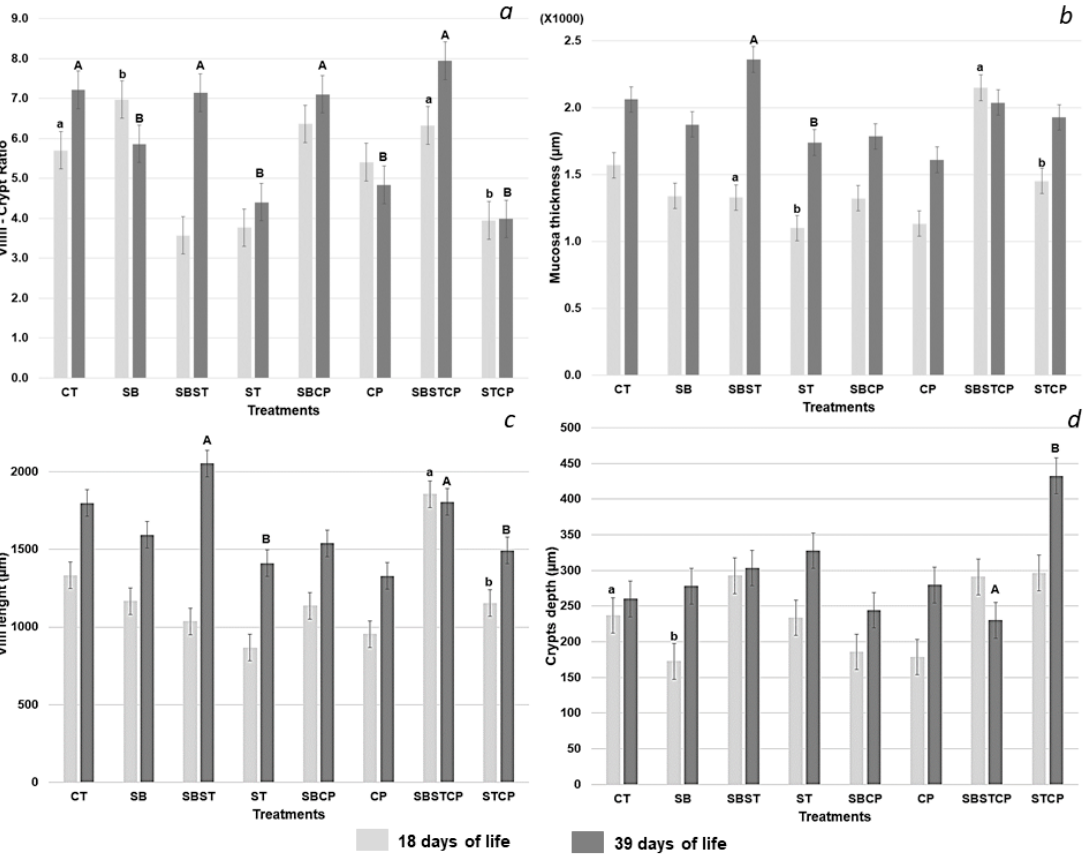
Figure 1. E ff ect of dietary supplementation with a Synbiotic mix on duodenum morphology of broilers Figure 1. Effect of dietary supplementation with a Synbiotic mix on duodenum morphology of challenged with Salmonella Typhimurium and Clostridium perfringens . ( a ) Villi–crypt ratio; ( b ) mucosa broilers challenged with Salmonella Typhimurium and Clostridium perfringens. ( a ) Villi–crypt ratio; ( b ) thickness ( µ m); ( c ) villi length ( µ m); and ( d ) crypts depth ( µ m). CT: non-challenged Control group; mucosa thickness (µm); ( c ) villi length (µm); and ( d ) crypts depth (µm). CT: non-challenged Control SB: Synbiotic; SBST: Synbiotic + S . Typhimurium; ST: S . Typhimurium; SBCP: Synbiotic + C. group; SB: Synbiotic; SBST: Synbiotic + S. Typhimurium; ST: S. Typhimurium; SBCP: Synbiotic + C. perfringens; CP: C. perfringens; SBSTCP: Synbiotic + S. Typhimurium + C. perfringens ; STCP: S. Typhimurium + C. perfringens. Means in the same row with different superscripts (a–b or A–B) differ (MANOVA p < 0.05).